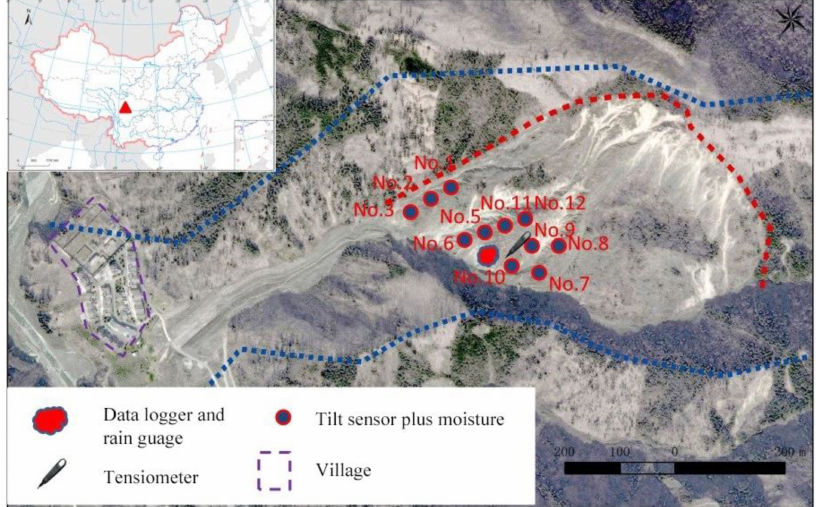
Figure 1. Location of the in situ monitoring site of the landslide in Yindongzi valley, Dujiangyan Country, Sichuan Province,